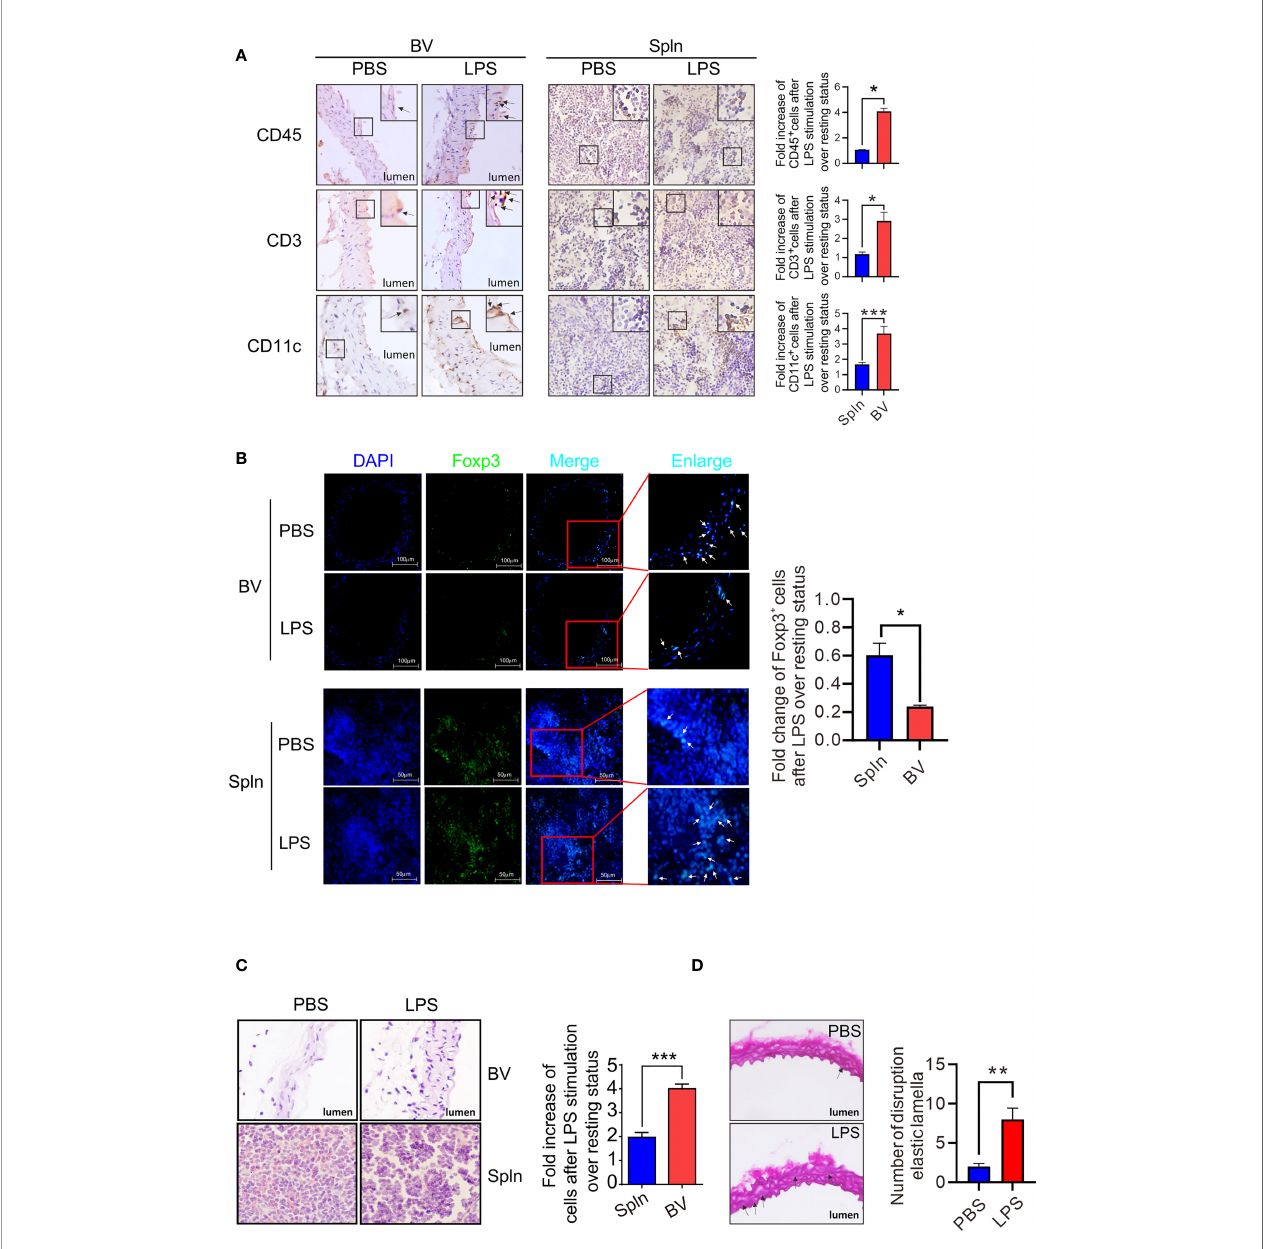
FIGURE 9 | Establishment of vascular in fl ammation induced by systemic infection. Mice were i.v. injected with LPS or PBS before their BV and Spln were taken to analyze the expression of makers for leukocytes, T cells, and DCs by immunohistochemistry (magni fi cation: ×40, with more magni fi ed pictures for the representative positive cells at the top right boxes) (A) , Tregs by immuno fl uorescence (magni fi cation: ×40) (B) , structure damages by HE staining in paraformaldehyde- fi xed sections (magni fi cation: ×100) (C) , and cross-sections of the aorta stained with Weigert coloration for elastic lamellae disruptions indicated by arrows (red: collagenous fi ber; atropurpureus and blue: elastic fi bers) (magni fi cation: ×40) (D) . Shown here are representative plots of at least two experiments performed. The data are shown as mean ± SEM and analyzed using Student ’ s t -test. * p < 0.05; ** p < 0.01; *** p <